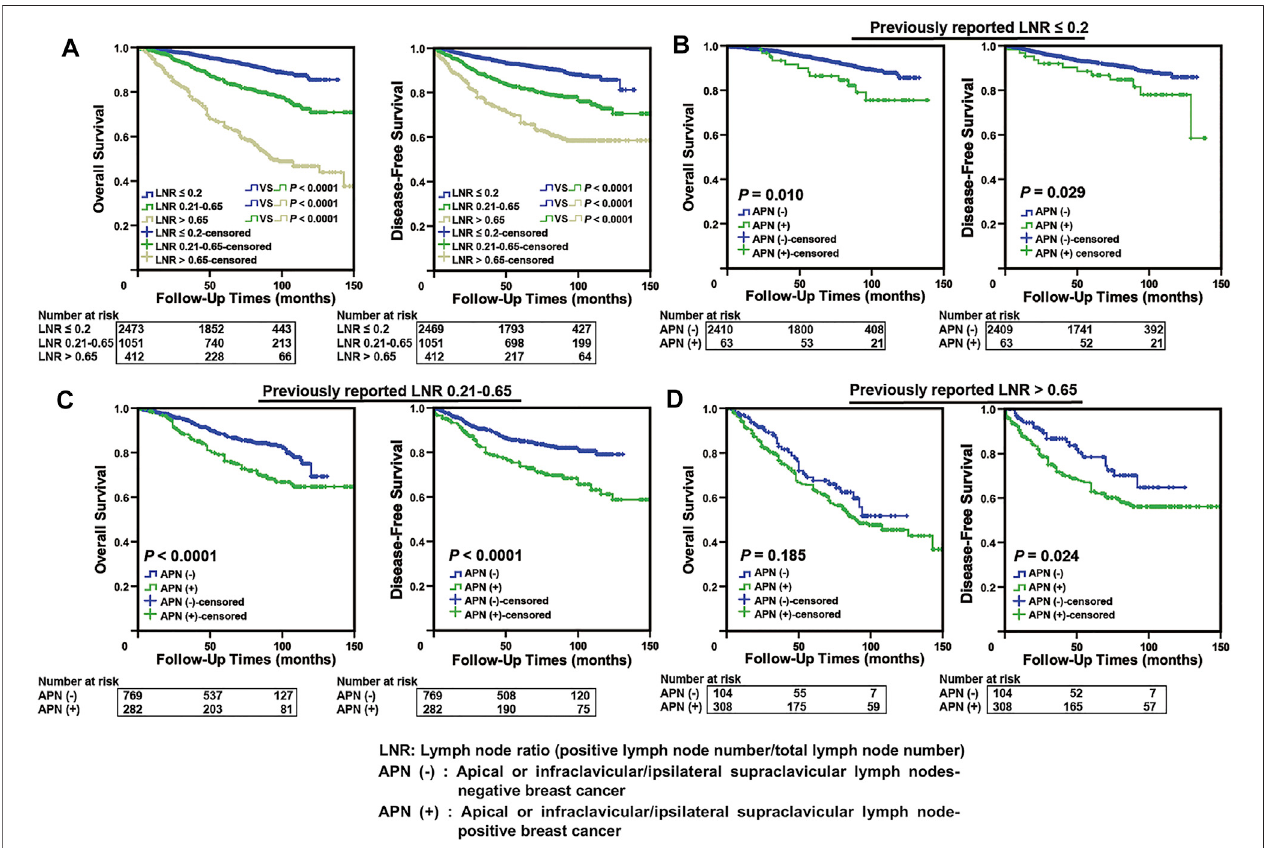
FIGURE2| Some APN(+) patients withpoorprognosiswere mis-subgrouped inthelowLNRstage usingtheLNR system. (A) Kaplan – Meieranalysisinourbreast cancer cohort according to previously reported LNR ( n = 3,936). (B) Comparison of Kaplan – Meier curves of APN( − ) and APN(+) breast cancer patients based on previously reported LNR ≤ 0.2 ( n = 2,473, OS: p = 0.010, DFS: p = 0.029). (C) Comparison ofKaplan – Meier curves of APN( − ) and APN(+) breast cancer patients based onpreviouslyreportedLNR0.21 – 0.65( n =1,051,OS: p < 0.0001,DFS: p < 0.0001). (D) Comparison ofKaplan – MeiercurvesofAPN( − )andAPN(+)breastcancer patients based on previously reported LNR > 0.65 ( n = 412, DFS: p = 0.024).